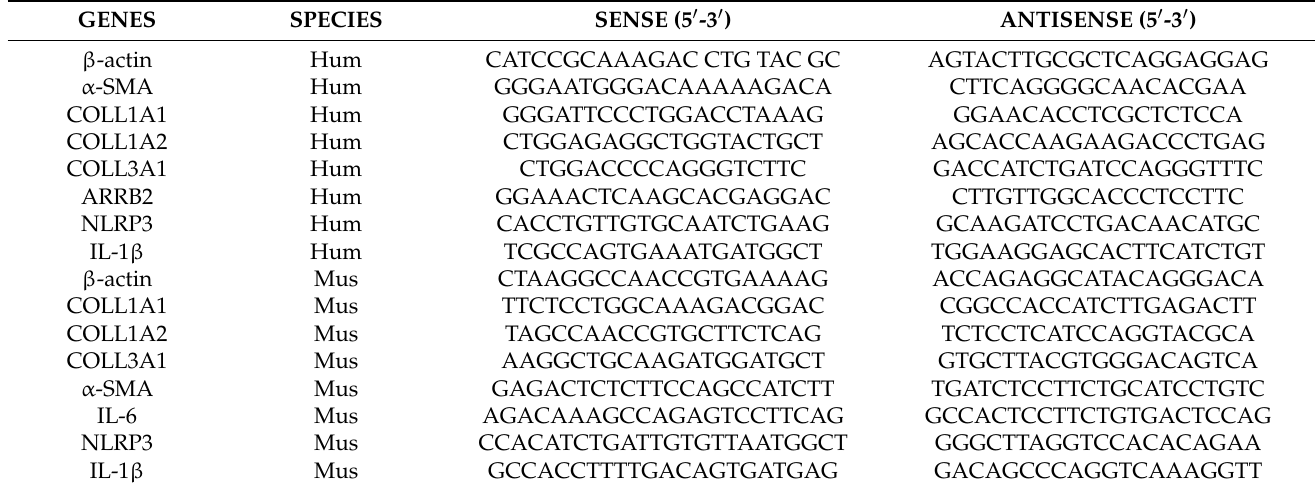
Table 1. Primers Used for Real-Time Polymerase Chain Reaction